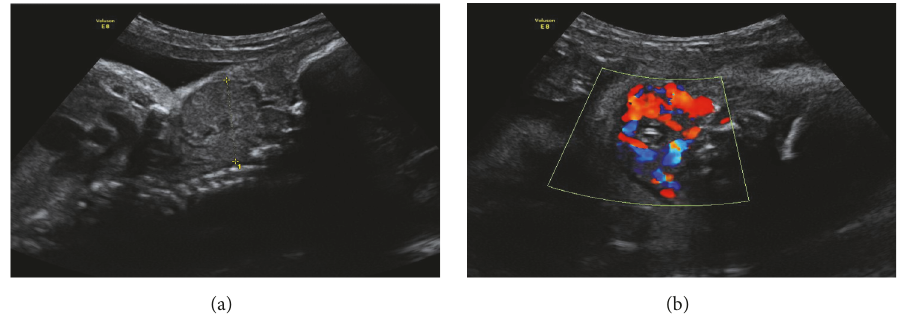
Figure 1: Fetal US by 29 weeks of gestation presenting a vascularized mass in fetal neck.